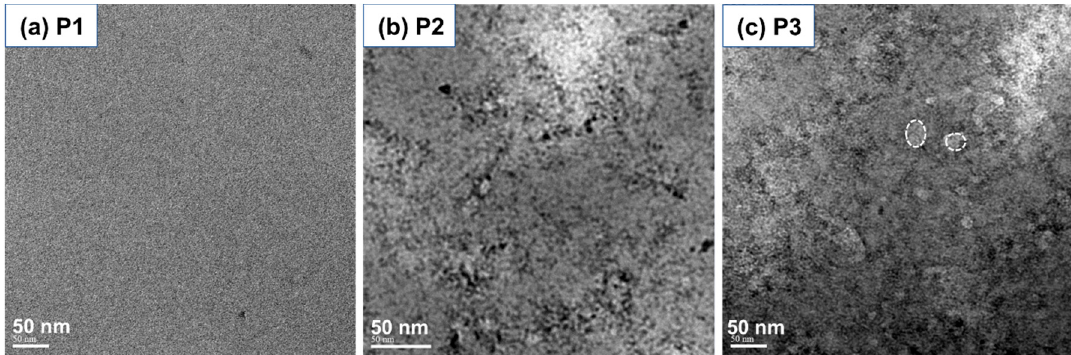
Figure 3. TEM images of ( a ) P1, ( b ) P2 and ( c ) P3.